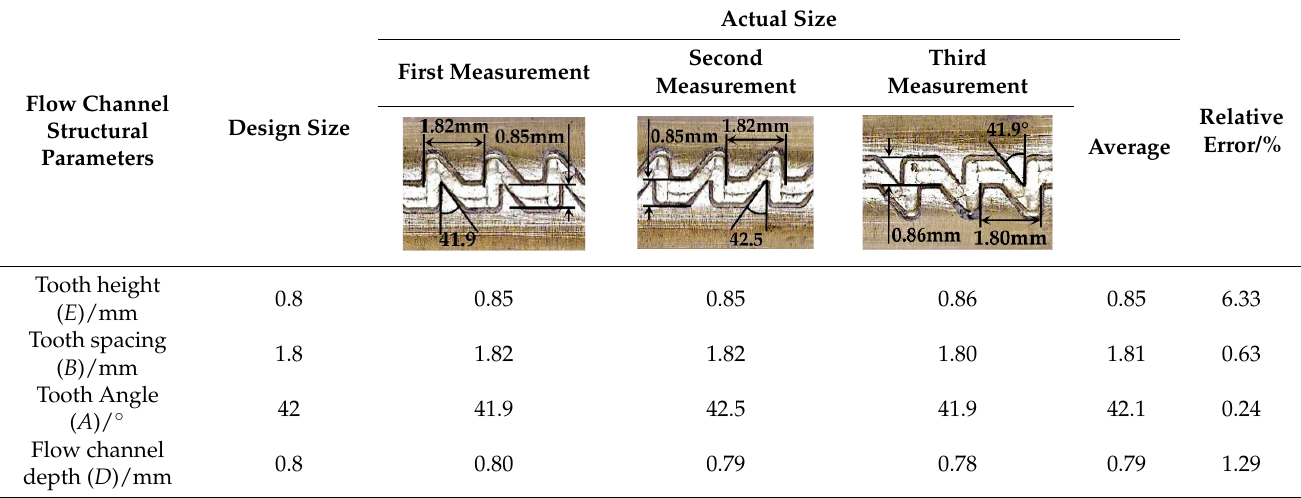
Table 10. Relative error between the measured flow rate ( q Im ) and the predicted flow rate ( q I ) when q Ⅰ 0.1 was 1.5 L/h based on the formula in Table 8.